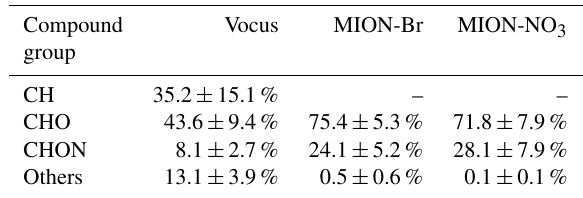
Table 1. Contribution (%, average ± 1 standard deviation) of differ- ent compound groups to total organics measured by different mea- surement